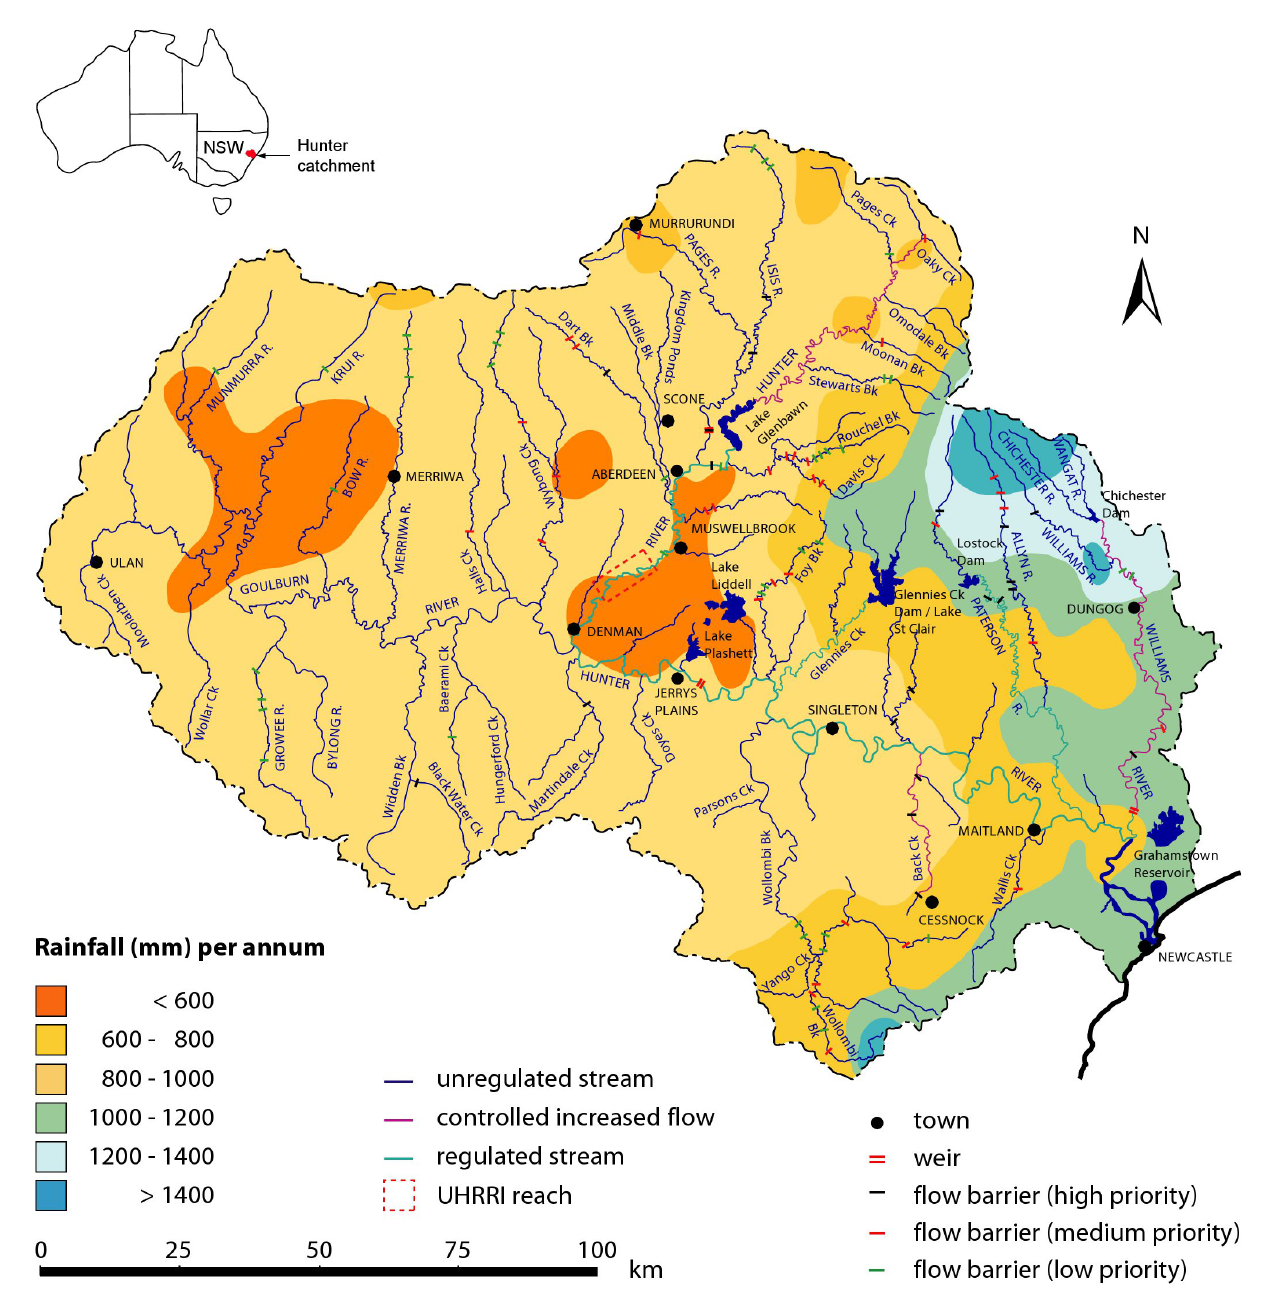
Fig. 1 . Rainfall, streamlines, impoundments, and flow barriers in the Hunter catchment. The UHRRI is the Upper Hunter River Rehabilitation Initiative. Rainfall data were sourced from the NSW Department of Land and Water Conservation (DLWC 2000). The extents of unregulated, controlled, and regulated flow as well as the locations of flow barriers were sourced from Ryder et al. (2008b). High, medium, and low priority refers to the priority for removal of flow barriers to improve fish